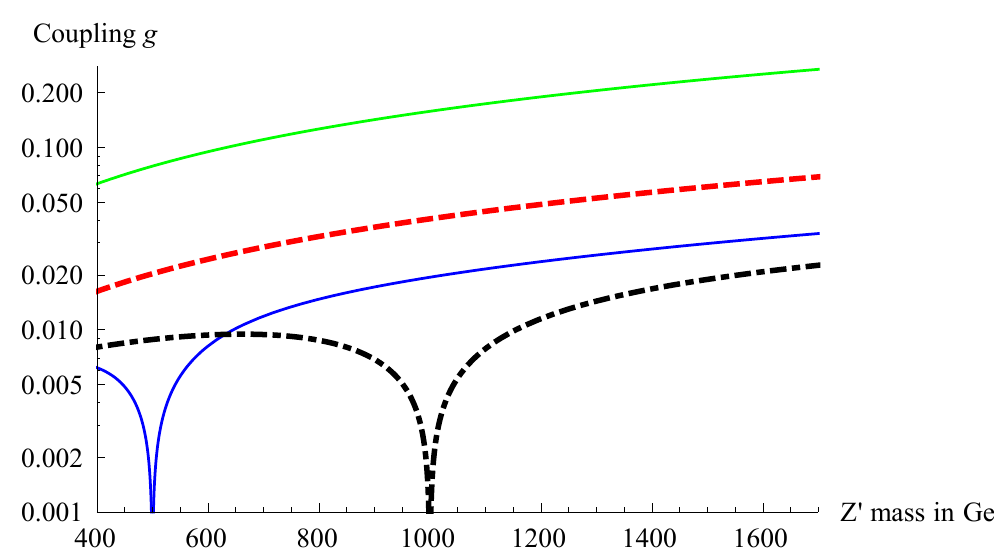
Figure 2 . Upper bound on g (cid:22)e as a function of M Z 0 coming from muon decay (red dashed curve) and from muonium-antimuonium oscillation (green continuous line). Value of g (cid:22)e that corresponds to one event/year as a function of M Z 0 with luminosity L =10 34 cm (cid:0) 2 s (cid:0) 1 and c.m.e. of 500 GeV (blue continuous line) and 1 TeV (dot-dashed line). Left and right couplings are assumed to be